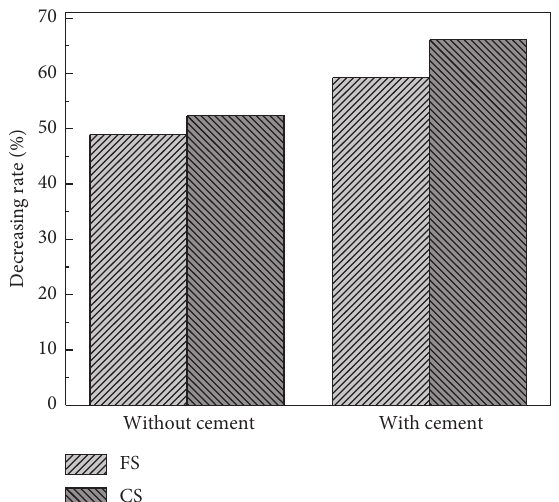
Figure 8: The strength decreasing rate of recycled plaster before and after adding aluminate